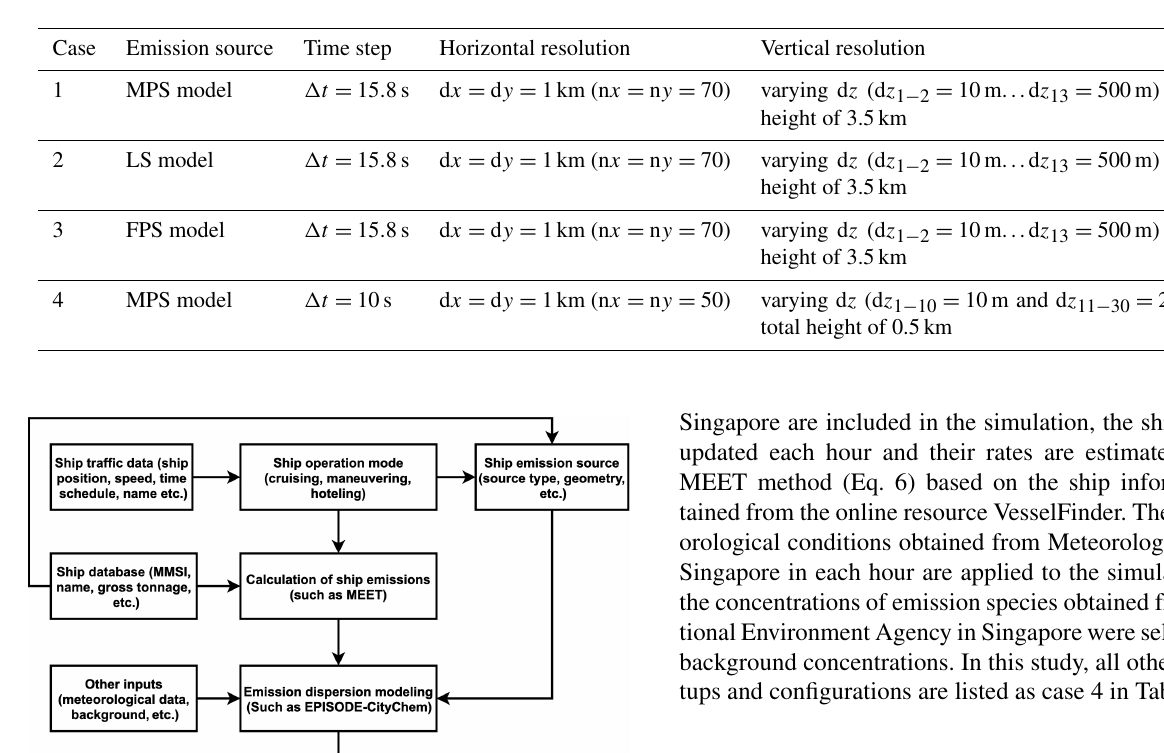
Table 3. Setups of shipping emission dispersion modeling.